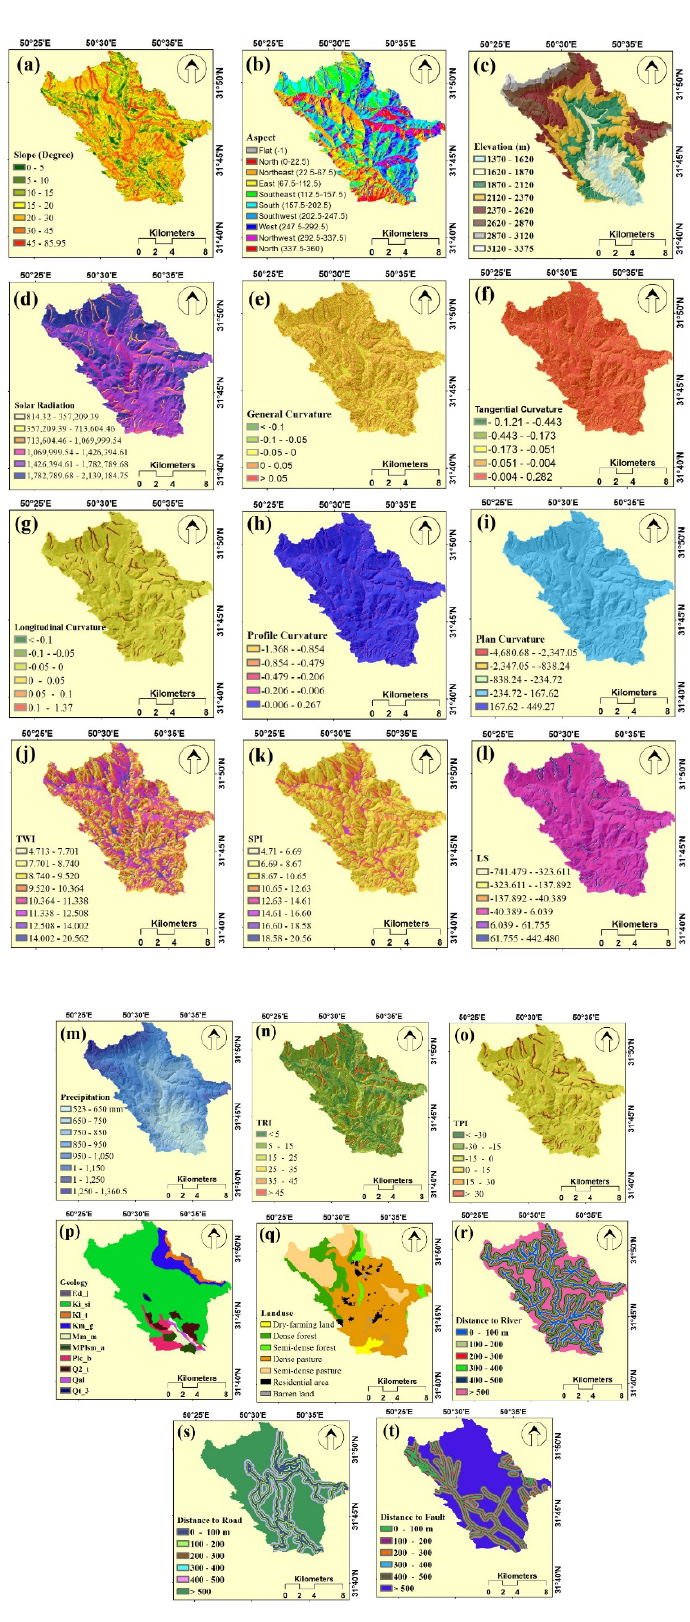
Figure 3. Landslide conditioning factors and their classes: ( a ) slope; ( b ) aspect; ( c ) elevation; ( d ) solar radiation; ( e ) general curvature; ( f ) tangential curvature; ( g ) longitudinal curvature; ( h ) profile curvature; ( i ) plan curvature; ( j ) TWI; ( k ) SPI; ( l ) LS; ( m ) precipitation; ( n ) TRI; ( o ) TPI; ( p ) geology; ( q ) land use; ( r ) distance to river; ( s ) distance to road; ( t ) distance to fault.